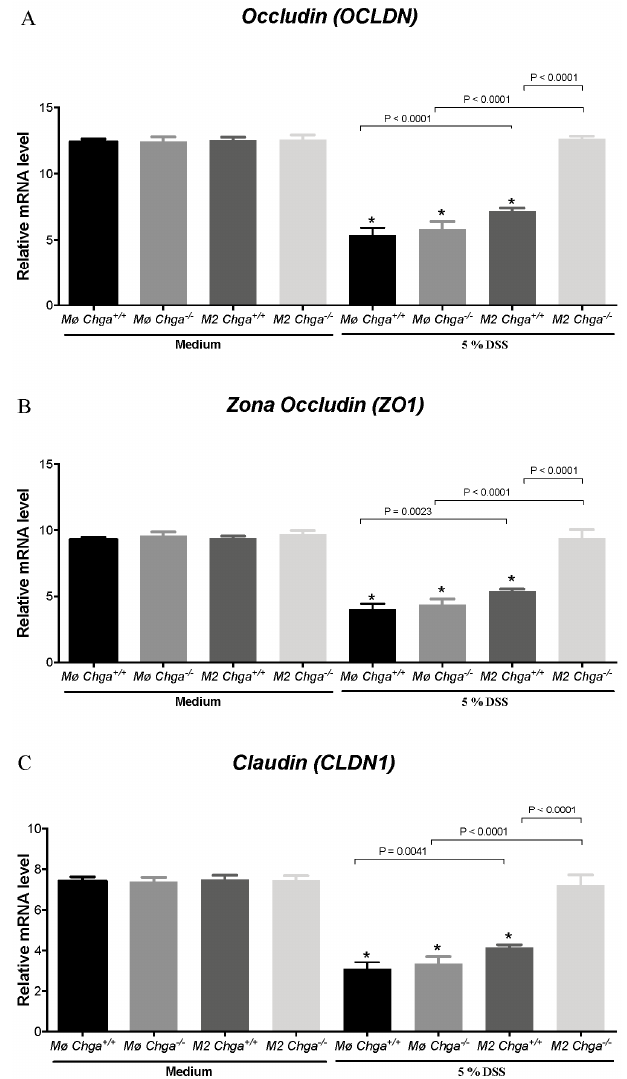
Figure 5. Chromogranin-A ( Chga )-deficient alternatively activated macrophages (M2)-conditioned supernatant maintains the levels of tight junction (TJ) proteins in dextran sulphate sodium (DSS)-stimulated Caco-2 epithelial cells. Caco-2 cells were seeded at 3 × 10 5 cells / well onto tissue culture plates and treated with 2 mL of non-conditioned supernatant (Mo) or M2-conditioned supernatant of wild-type ( Chga +/+ ) and Chga -knockout ( Chga − / − ) for 24 h. Then cells were challenged with 5% DSS or regular medium for an additional 24 h. ( A – C ) Tight junction (TJ) proteins (occludin [ OCLN ], zonula occludens-1 [ ZO1 ], claudin [ CLDN1 ]) mRNA expression quantified by RT-qPCR in DSS-stimulated epithelial cells. One-way ANOVA followed by Tukey’s multiple comparison tests. Each value represents the mean ± SEM n = 6–9 per group. * p <0.05 refers to significance compared with medium groups. Each experiment was repeated at least three times.